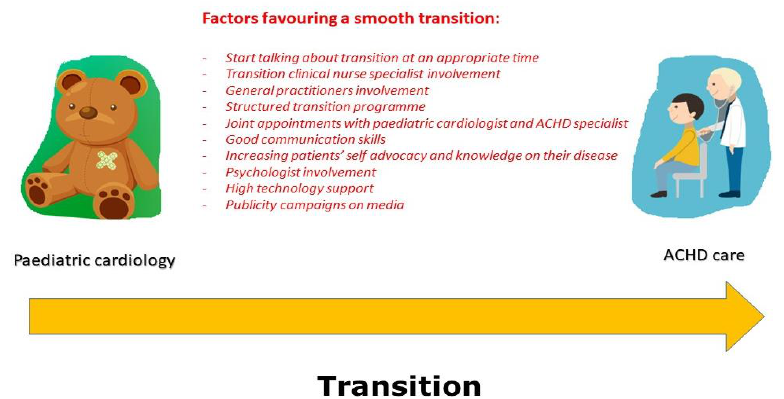
Figure 3. Strategies for a smooth transition from paediatric to adult CHD services.